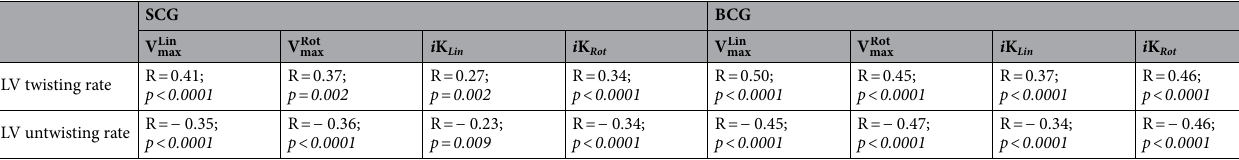
Table 3. Associations of velocities from SCG and BCG with LV twisting and untwisting rates from 2D STI echocardiography. Spearman’s correlation of velocities and i K computed from the SCG and BCG signals in both linear and rotational channels with LV twisting and untwisting rates obtained from 2D STI Lin echocardiography. Statistical significance was set at 0.05 and emphasized in italics. V Max maximal velocity Rot in the linear channel (mm/s/m 2 ), V Max maximal velocity in the rotational channel (°/s/m 2 ), i K Lin integral of kinetic energy in the linear channel (µJ s/m 2 ), i K Rot integral of kinetic energy in the rotational channel (µJ s/ m 2 ).